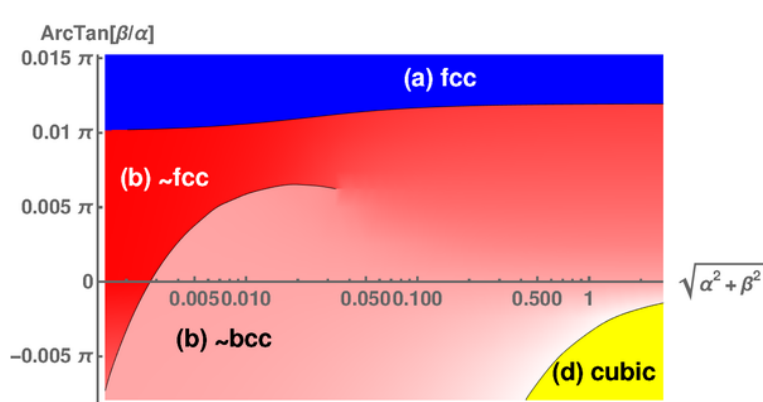
Figure 14: The phase diagram for the non-Abelian crystals near β = 0 in angular coordinates. Notice that the horizontal axis is in logarithmic scale. Notation as in fig. 10